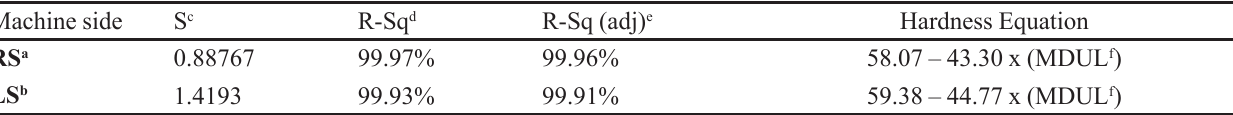
TABLE VI - Hardness equations for RS and LS of tablet machine Machine